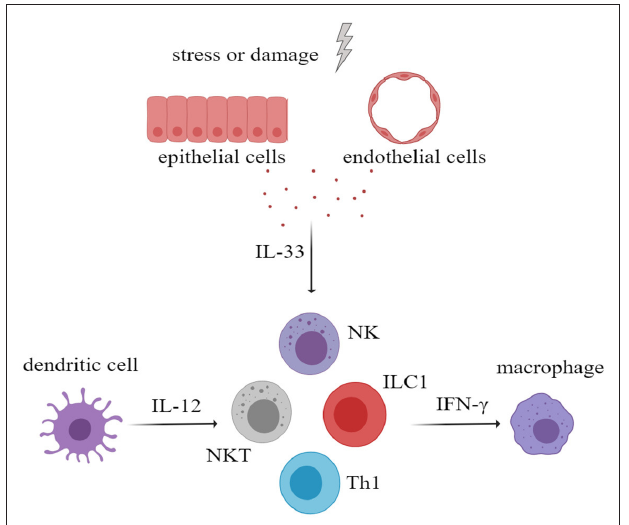
FIGURE 3 | After activation of innate immune cells, especially myeloid dendritic cells, large amounts of interleukin-12 (IL-12) were secreted. IL-33 and IL-12 had a synergistic effect in stimulating NK cells, NKT cells, ILC1, and Th1 to secrete more IFN- γ , which will aggravate tissue damage. NK cells, natural killer cells; NKT cell, natural killer T cell; ILC, innate lymphoid cell. FIGURE 4 | Interleukin-33 (IL-33) could promote tissue repair and fibrosis.